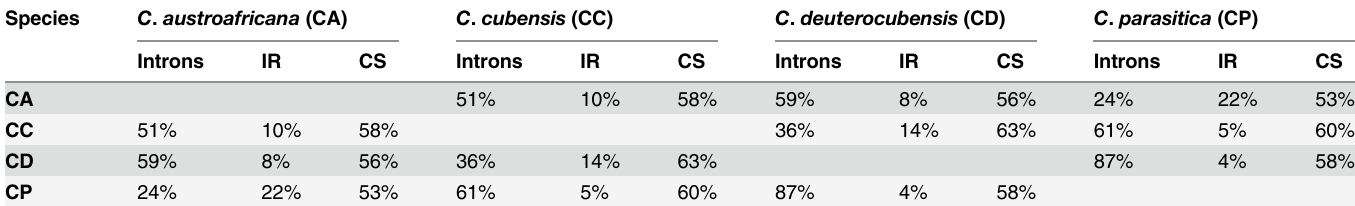
Table 5. Comparison of factors contributing to genome size polymorphism. Pairwise comparisons were calculated for introns, intergenic regions (IR) and coding sequences